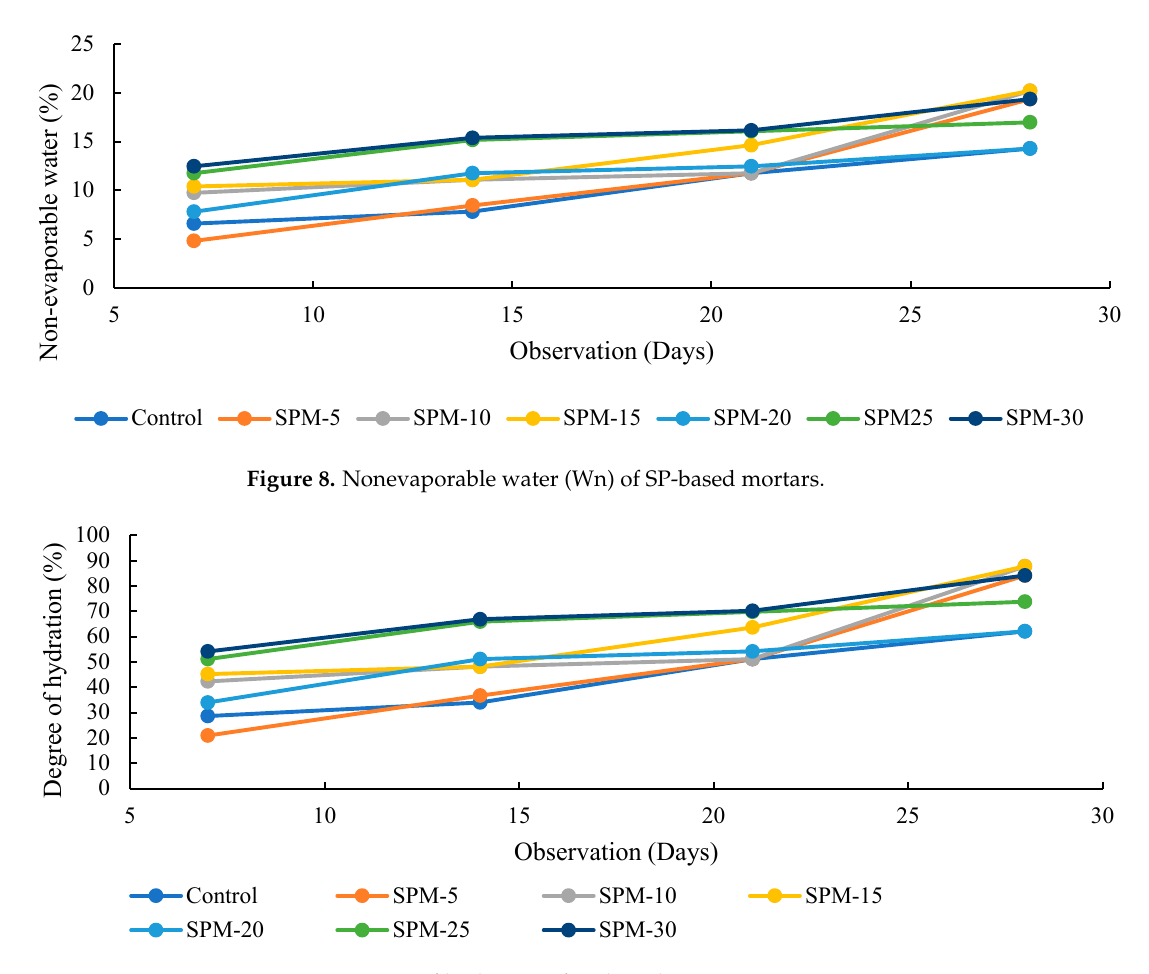
Figure 7. Loss on ignition (LOI) of SP-based mortars.